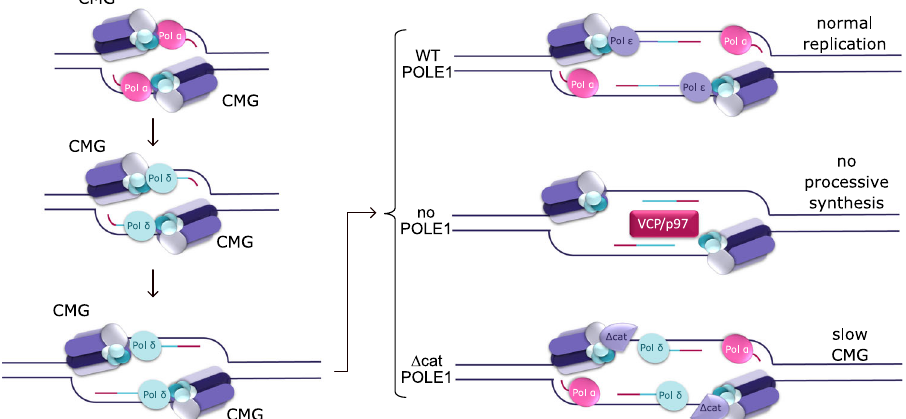
Fig. 7 | Proposed model of DNA replication initiation in human cells with and without POLE1, as well as in presence of Δ cat. POLE may be present at the early stages of origin fi ring, but according to our data it is not necessary. Under normal conditions, POLE replaces POLD as a leading strand polymerase. In the absence of